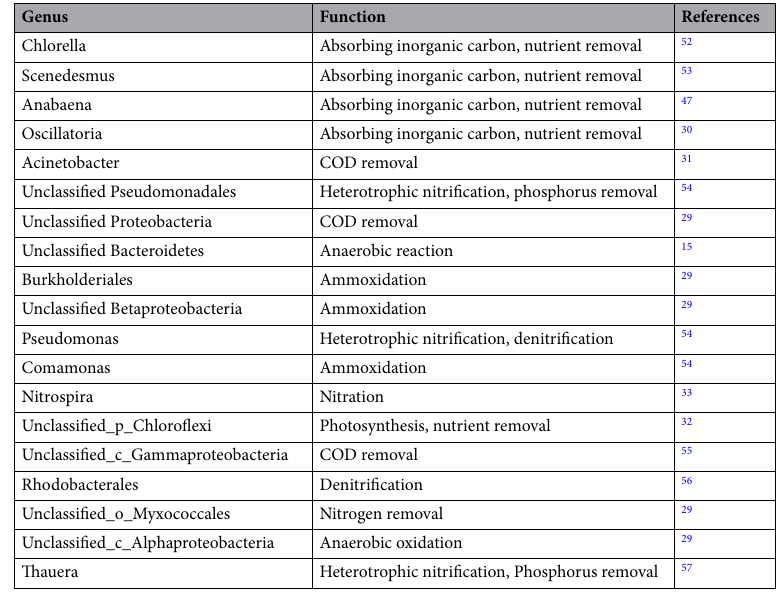
Table 3. The function and abundance of the bacteria in genus in reactors at different